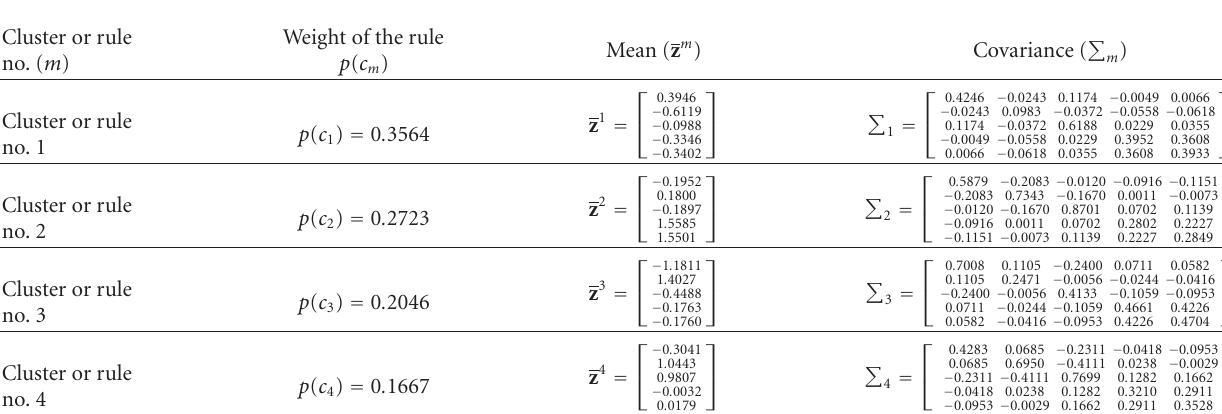
Table 7: Estimated parameters of A 4-component GMM using the EM algorithm.